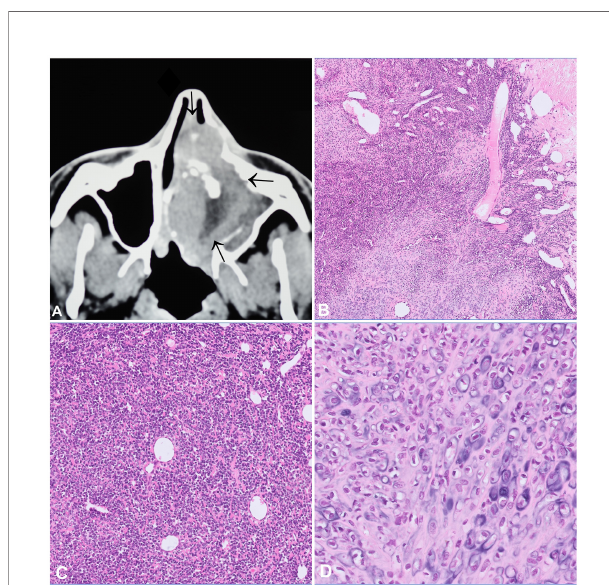
FIGURE 2 | Mesenchymal chondrosarcoma. (A) CT scan showing an aggressive tumour of the nasal cavity with internal focal mineralisation, osteodestruction, and in fi ltration into the adjacent structures. (B – D) Mesenchymal chondrosarcoma with a characteristic biphasic pattern consisting of an undifferentiated small cell component with a characteristic haemangiopricytoma-like vascular pattern (B, C) , merging with islands of mature appearing cartilaginous component (D)